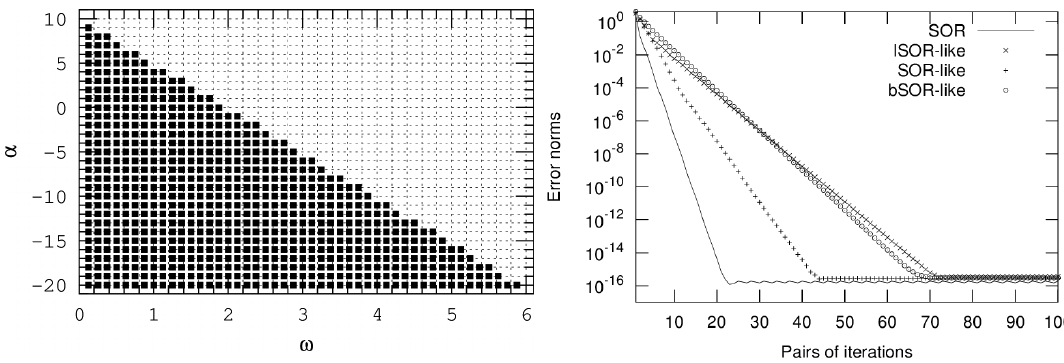
Fig. 7. Pairs .˛;!/ for which bSOR-like converged. Fig. 8. Convergence comparison for .˛;!/ D .3;1:25/